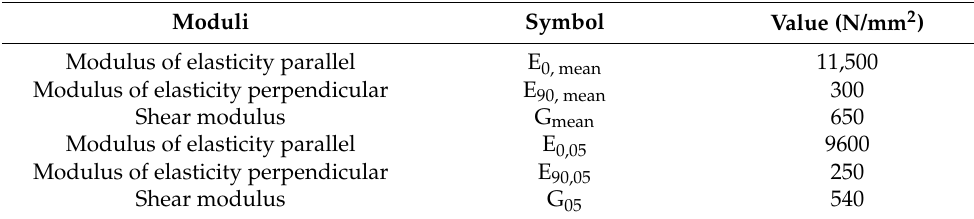
Table 2. FEM—material